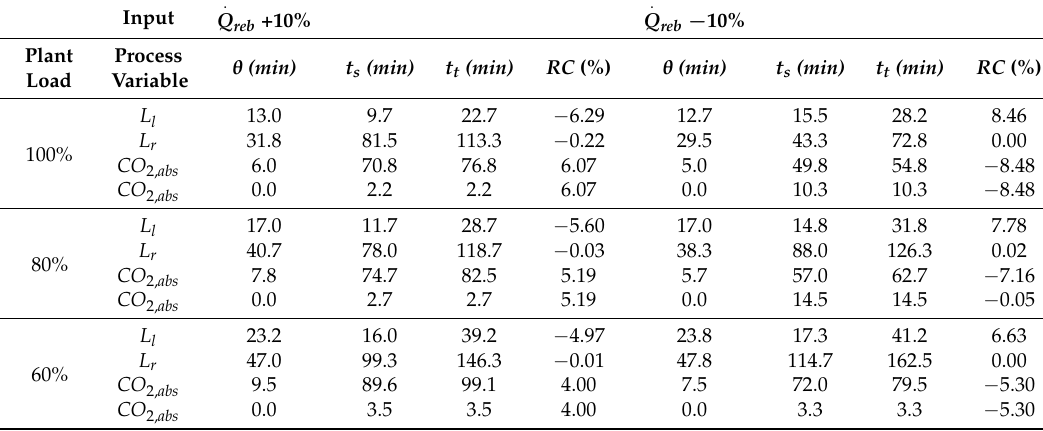
Table A3. Open-loop response to ± 10% step-changes in reboiler duty for three different operating points of the pilot plant. Responses in CO 2 lean loading L l , CO 2 rich loading L r , CO 2 absorbed, and CO 2